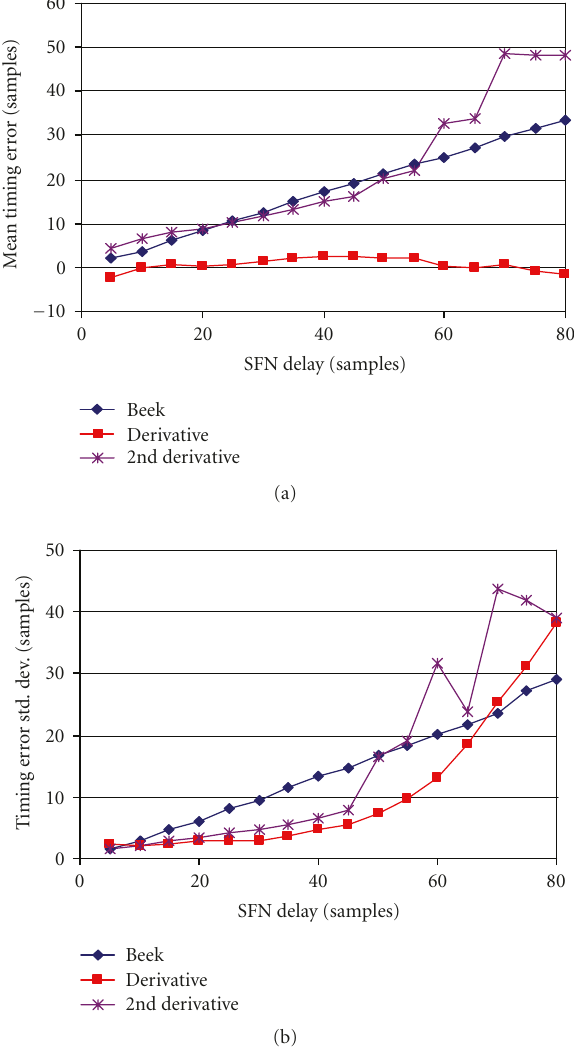
Figure 5: Timing-error performance comparison as a function of SFN